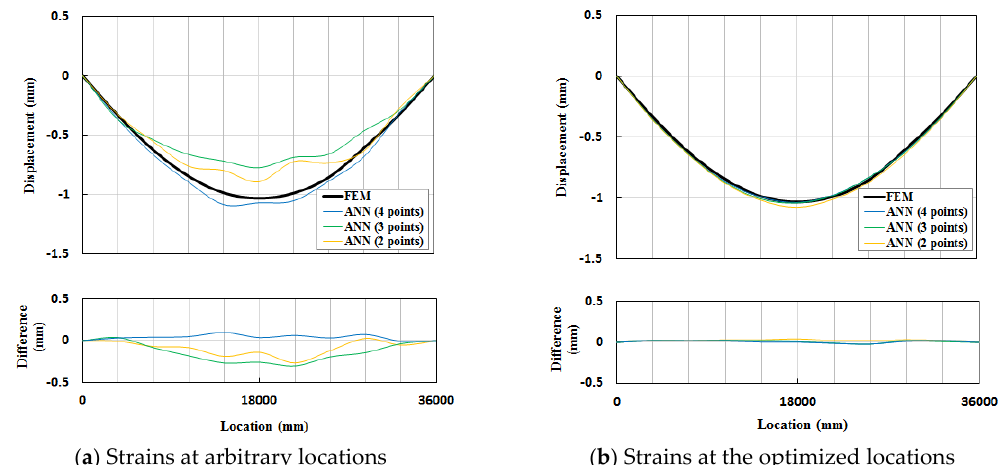
Figure 14. Overall displacements shape at t = 6.52 s (max. displacement) for the 40 km/h test dataset.